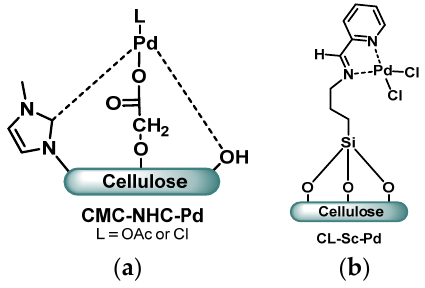
Figure 2. ( a ) Pd(II) complex supported by carboxymethylcellulose derivatized with